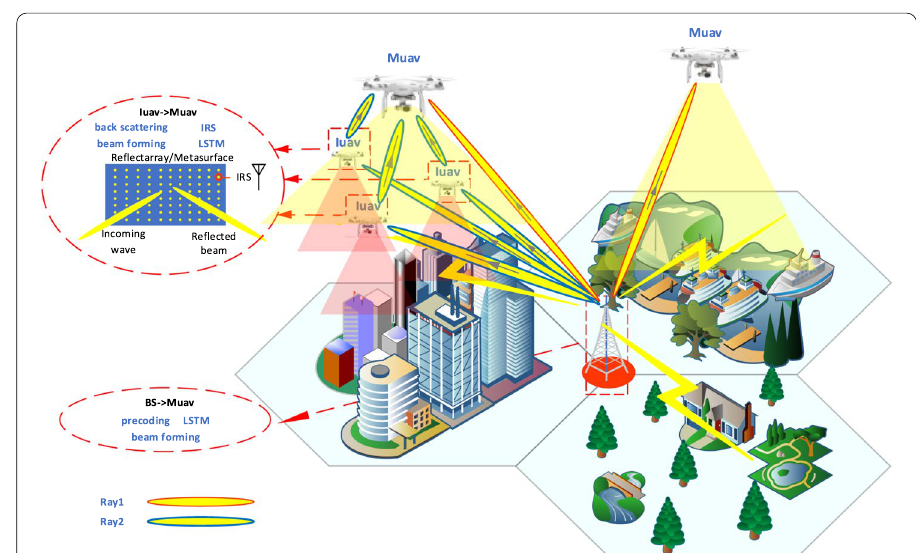
Fig. 1 BackCom communications between leader UAV and member